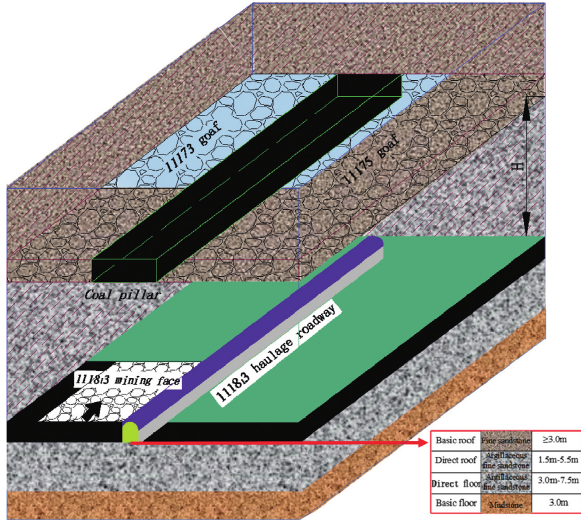
Figure 1: Diagram of the roadway